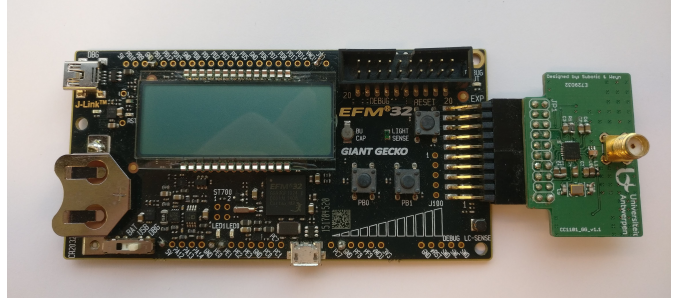
Figure 13. Hardware that is used in the Campus Paardenmarkt (CPM) environment for transmitter and receiver.